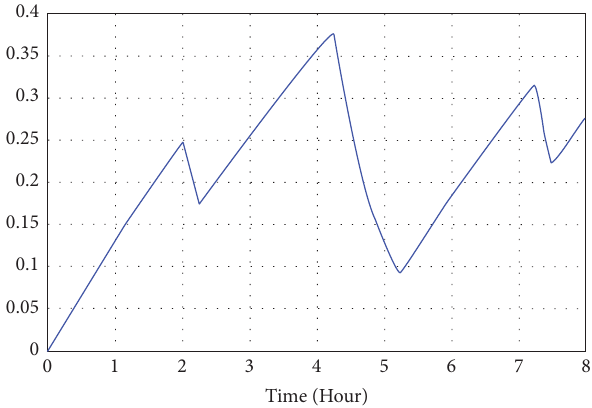
Figure 3: Workers’ stress when the stress relief rate is 30%.